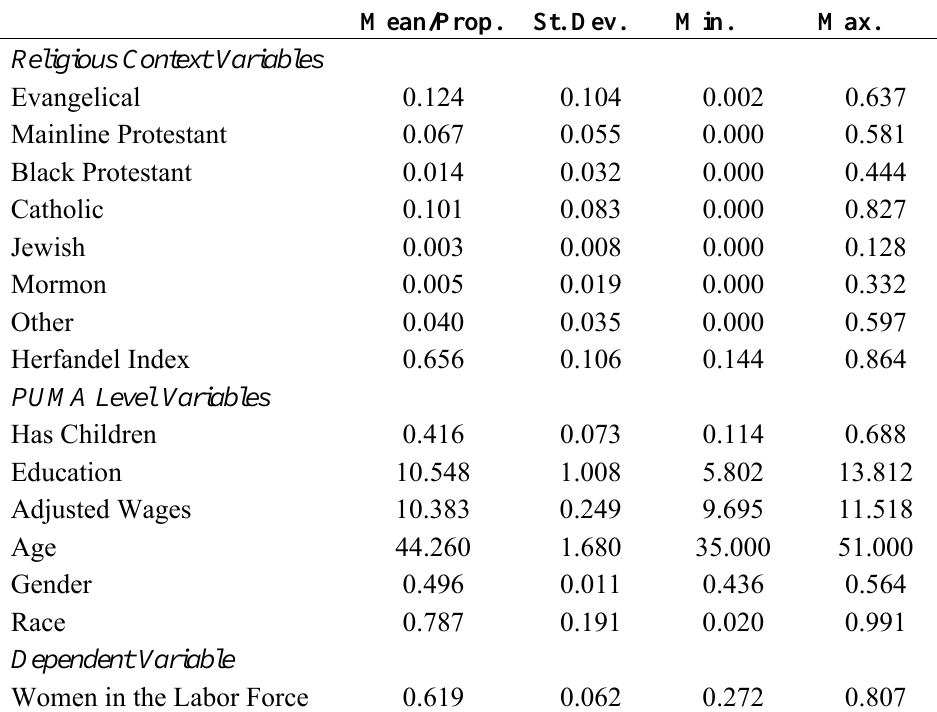
Table 1. Descriptive statistics.